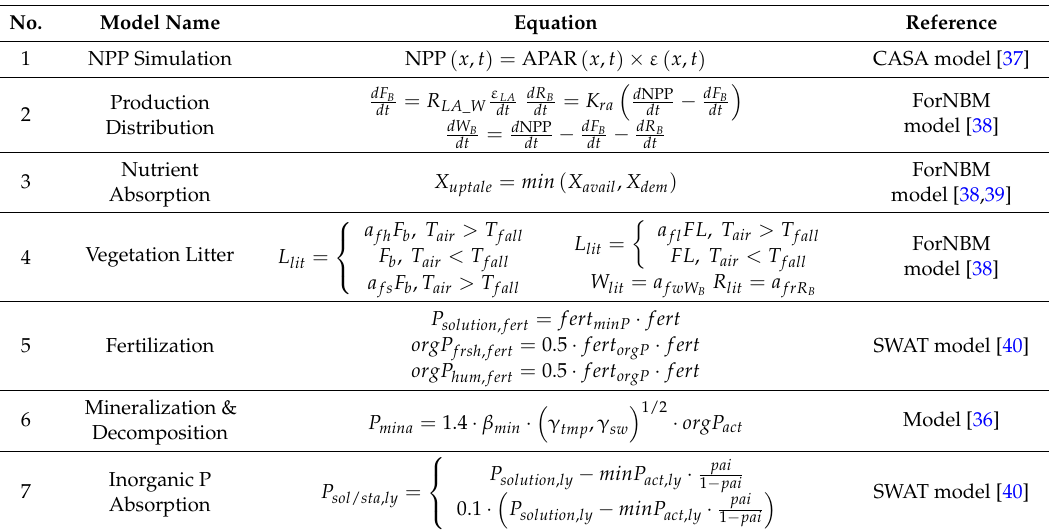
Table 3. Functions and parameters in the P